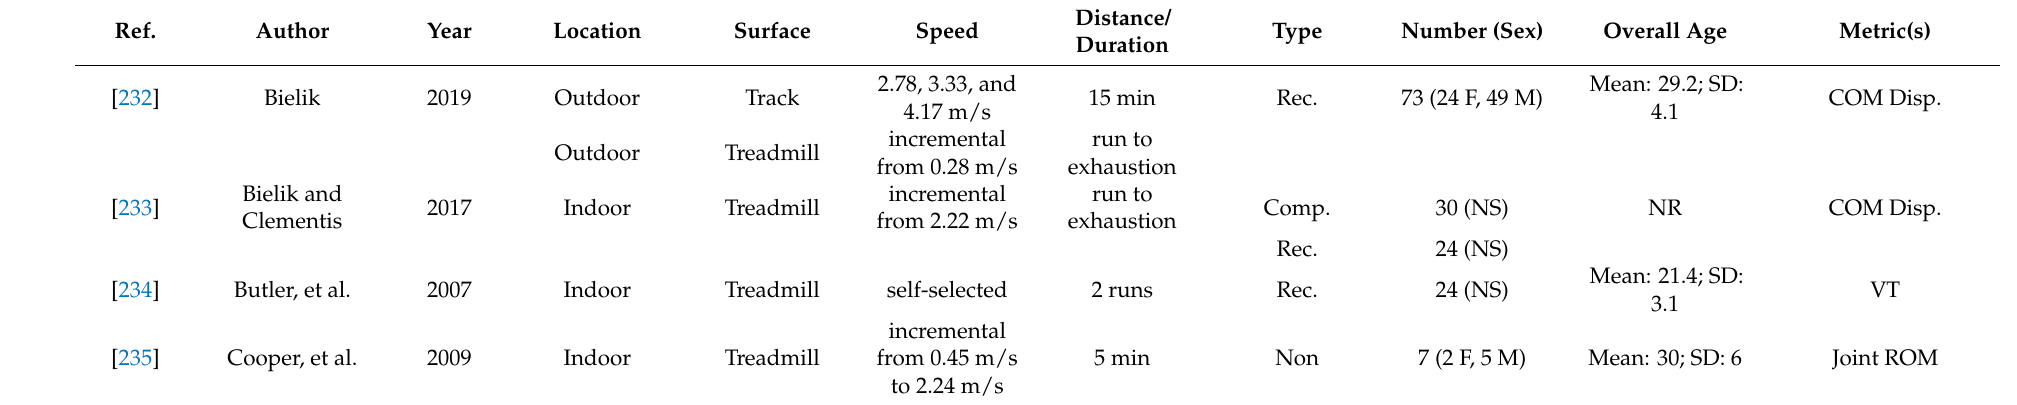
Table 6. Study characteristics where the analyzed distance is not